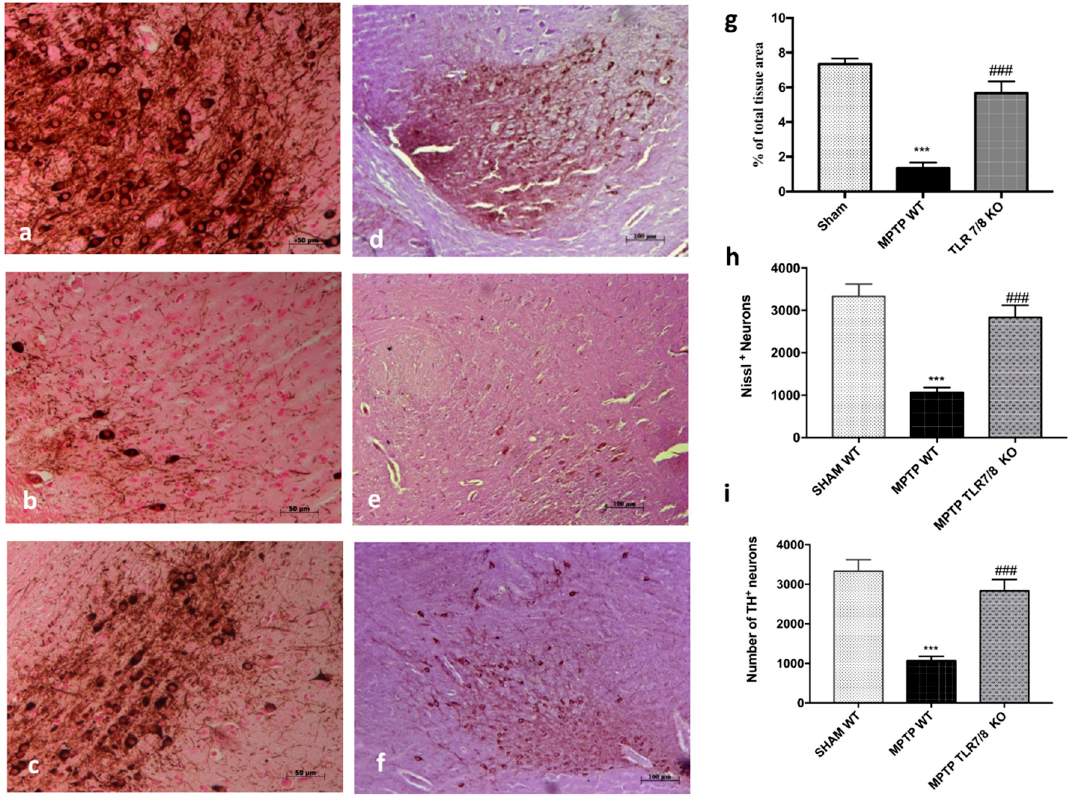
Figure 5. E ff ect of TLR7 / 8 on TH expression. Immunohistochemical analysis of midbrain obtained from WT mice after MPTP intoxication revealed a marked loss of TH-positive cells ( b ; see densitometric analysis, g ) compared with SHAM ( a ; see densitometric analysis, g ). TLR7 / 8 KO mice, subjected to MPTP, revealed an increase of positive staining for TH ( c ; see densitometric analysis, g ). Data are expressed as a percentage of total tissue area and are means ± SE of 10 mice / group *** p < 0.001 vs. SHAM; ### p < 0.001 vs. MPTP WT. Stereological counting of TH-positive and cresyl-violet positive neurons in sections of the SN from one hemisphere ( i , h , respectively). Representative images of TH immunohistochemistry of midbrain sections and counterstained with cresyl violet ( d – f ). Each data are expressed as a number of TH + and Nissl + neurons and are mean ± SEM from N = 10 mice / group. *** p < 0.001 vs. SHAM; ### p < 0.001 vs. MPTP WT ( h , i ).